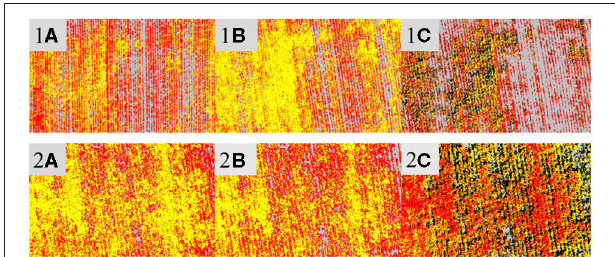
FIGURE 1 | Supervised classification method ( A : red-blue-green [RGB]; B : unfiltered multispectral; C : filtered multispectral) to distinguish between Italian ryegrass (yellow) from winter wheat (red) across imagery dates (1: February; 2: March) in 2016. Supervised classification was conducted with imagery acquired with an unmanned aerial vehicle equipped with a multispectral sensor. Red-blue-green classification accuracy did not change across imagery dates ( < 30%). Unfiltered multispectral classification accuracy decreased across imagery dates (February: 91%; March: 67%). Filtered multispectral classification increased across imagery dates (February: 94%; March: